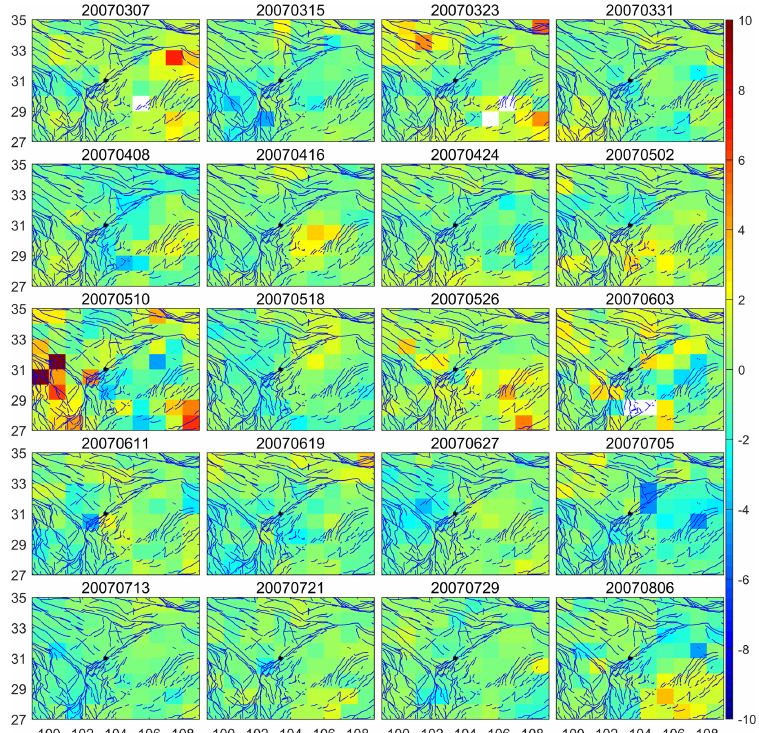
Figure 12. ALICE index of 8d CH 4 VMR at 300hPa during 2007.